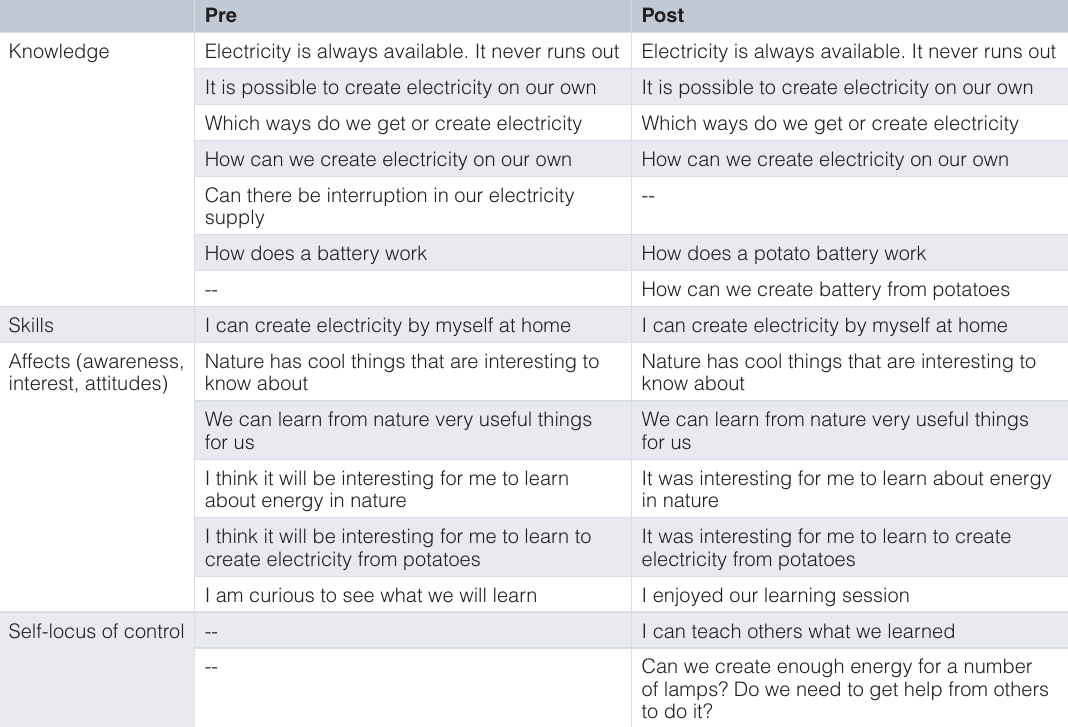
Table 1. Pre- and post-learning activity questions, addressing the major elements of environmental literacy.